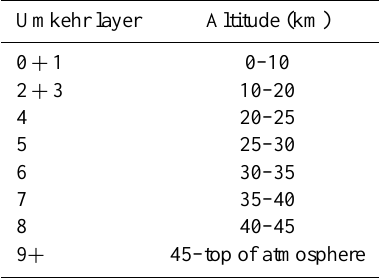
Table 1. Umkehr layer